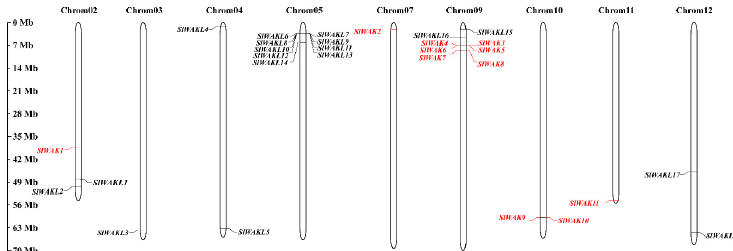
Figure 4. Chromosome distribution and duplication events of tomato SlWAK-RLK genes. Chromosome localization is based on the physical location (Mb) of 12 tomato chromosomes. Chromosome numbers are displayed at the top of each bar chart. The red indicates the SlWAKs , and the black represents the SlWAKLs . The locations of tomato SlWAK-RLK genes in chromosomes were obtained from the Sol Genomics Network database (http://solgenomics.net). Scale represents 70 Mb chromosomal distance.